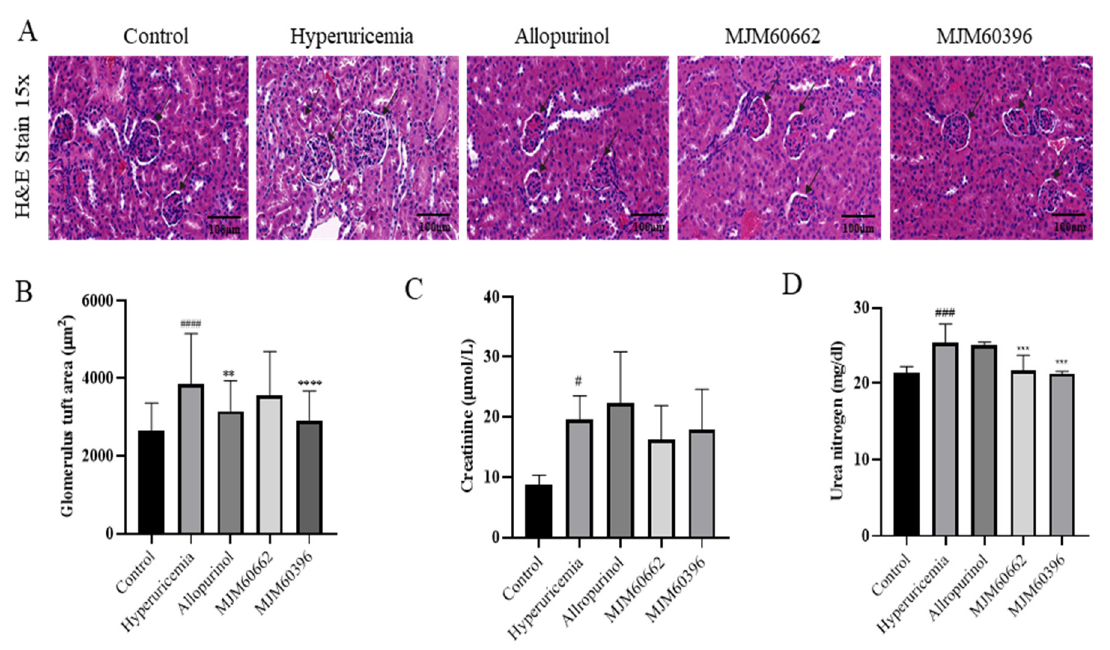
Figure 4. Kidney H&E staining and creatinine, urea nitrogen level in serum. ( A ) Effect of MJM60396, commercial strain and allopurinol on renal histopathology of hyperuricemia mice at magnification of 15 × H & E staining. ( B ) The level of glomerulus tuft area. ( C ) The level of serum creatinine. ( D ) The level of serum urea nitrogen. Data are presented as means ± SE of 6 different mice. # p < 0.05, ### p < 0.001, #### p < 0.0001 compare with control group, ** p = 0.01, *** p < 0.001, **** p < 0.0001 compared with hyperuricemia group. Scale bar: magnification of 15× = 100 µm.